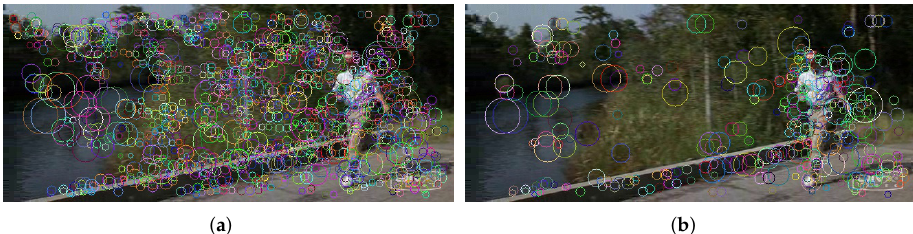
Figure 14. Illustration of SURF points after optimizing optical flow field. ( a ) Initial SURF points. ( b ) SURF points after optimizing optical flow filter.